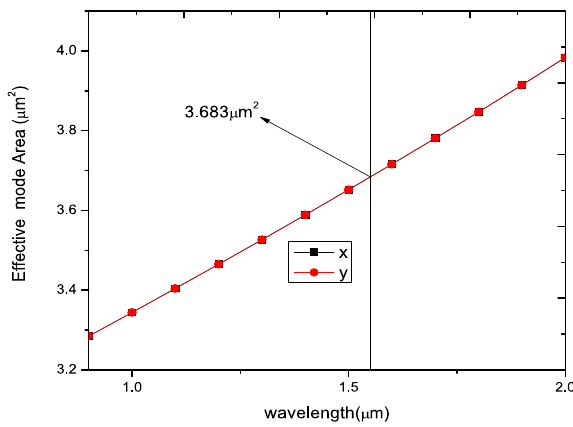
Fig. 7 Effective mode area as a function of wavelength Λ